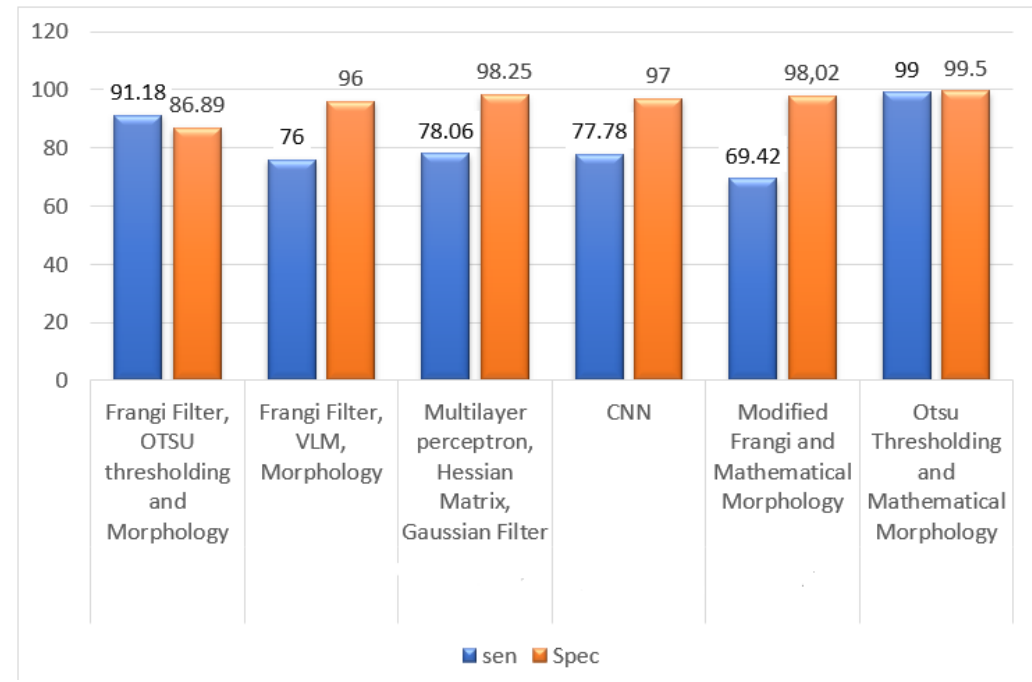
Figure 9. Blood vessel segmentation analysis.